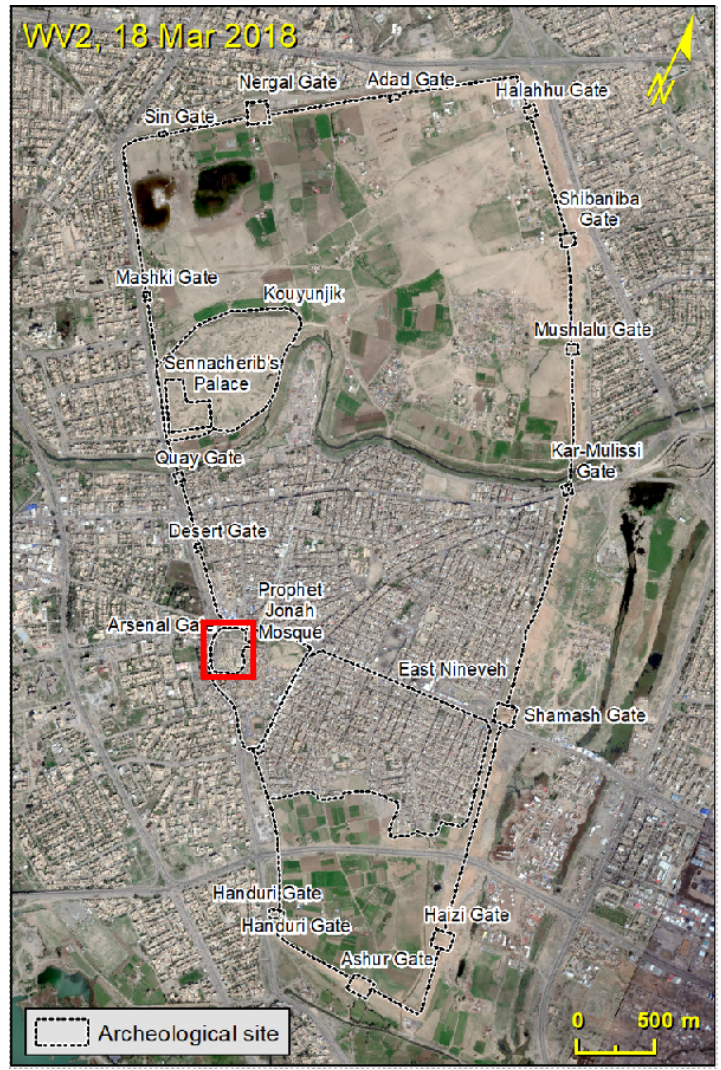
Figure 14. Nebi Yunus location—WorldView-2, 18 March 2018 c (cid:13)